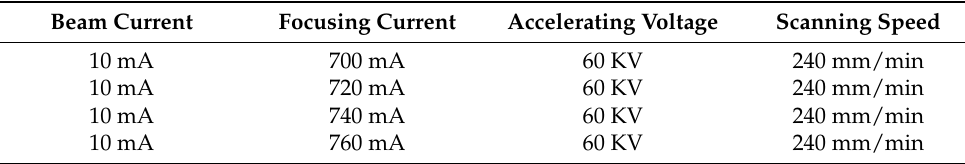
Figure 1. Experimental Flow Chart. Table 2. Electron beam scanning process parameters.